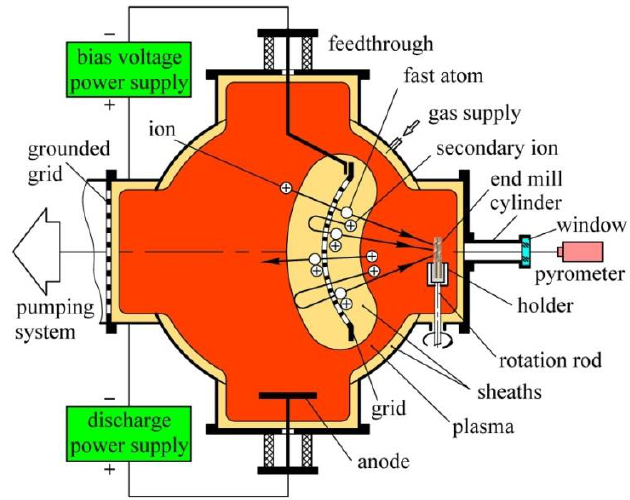
Figure 6. Scheme of a beam generation by a grid immersed in plasma. On the grid surface, holes with a diameter of 7 mm are evenly distributed at a distance of 8 mm between their centers. At a distance of 6 cm from the chamber wall is installed a rotating holder for the tools being processed by the beam. The axis of the holder rotation passes through the focal point of the concave grid